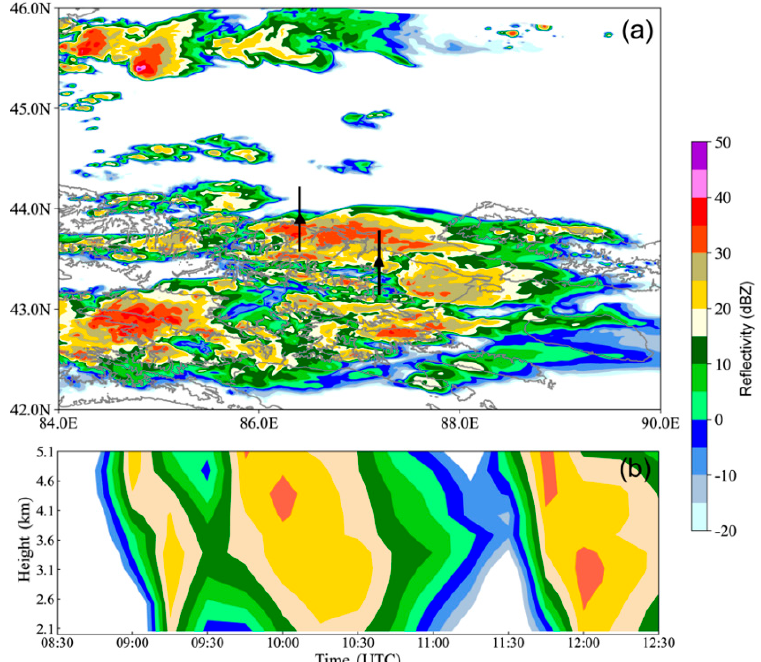
Figure 10. ( a ) Map of composite reflectivity at 9:00 UTC modeled by WRF; ( b ) Time − height diagram of the modeled reflectivity at the observational site. The two black lines indicate the cross-sections, which will be analyzed in Section 3.2.2.